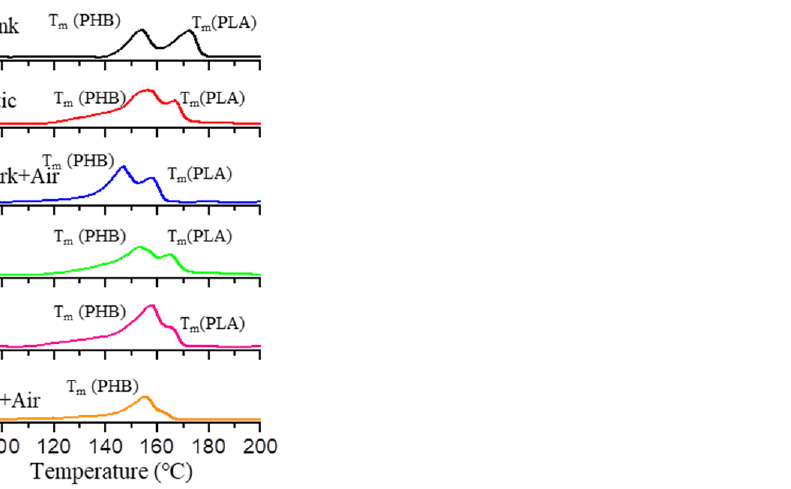
Figure 6. DSC thermograms of PLA/PHB fabrics at a heating rate of 20 °C/min before and after different conditions.